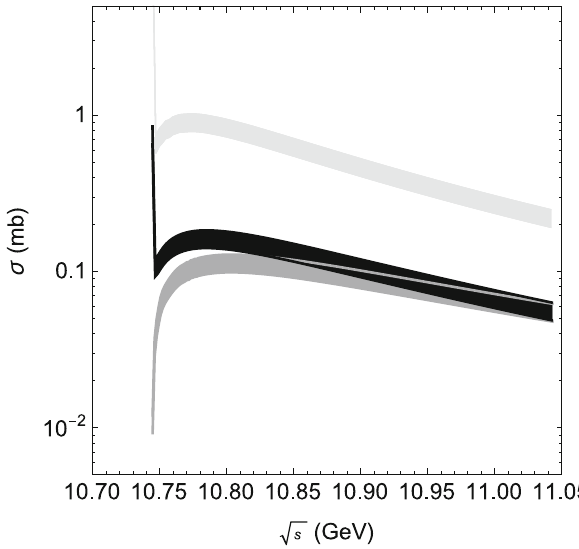
Fig. 3 Cross sections for the absorption processes π Z b → ¯ BB (medium shaded region), π Z b → ¯ B ∗ B (dark shaded region) and π Z → ¯ B ∗ B ∗ (light shaded region), as function of CM energy b